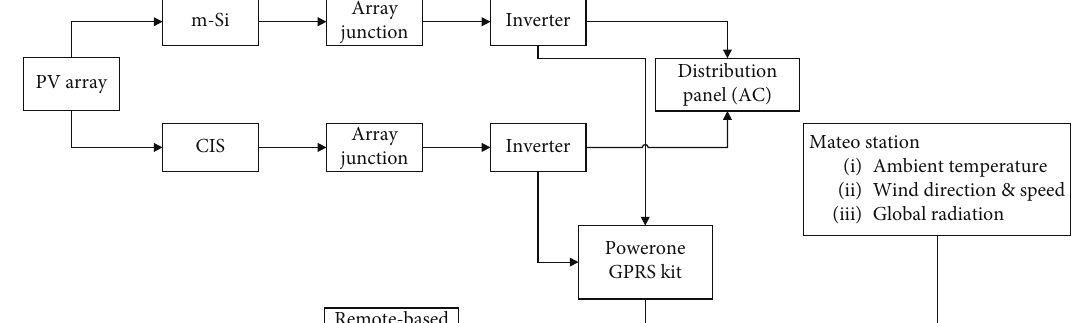
Figure 1: Grid-connected PV module ’ s con fi guration.